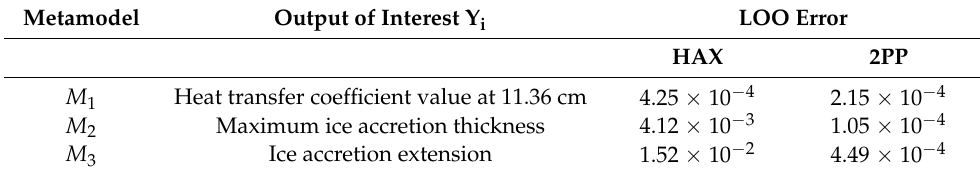
Table 3. Leave-one-out (LOO) errors for all the metamodels.